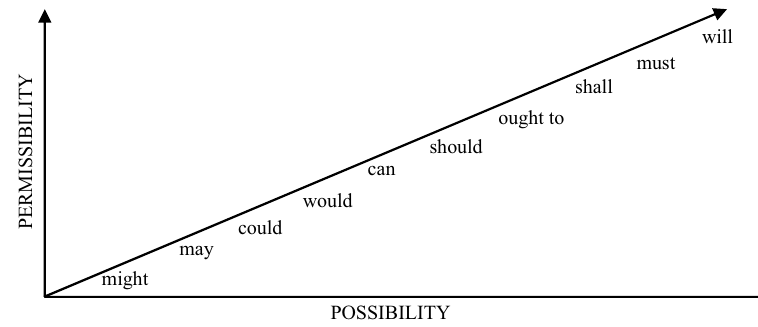
Figure 1: Illustrative cline of modal possibility ( X ) and permissibility ( Y )